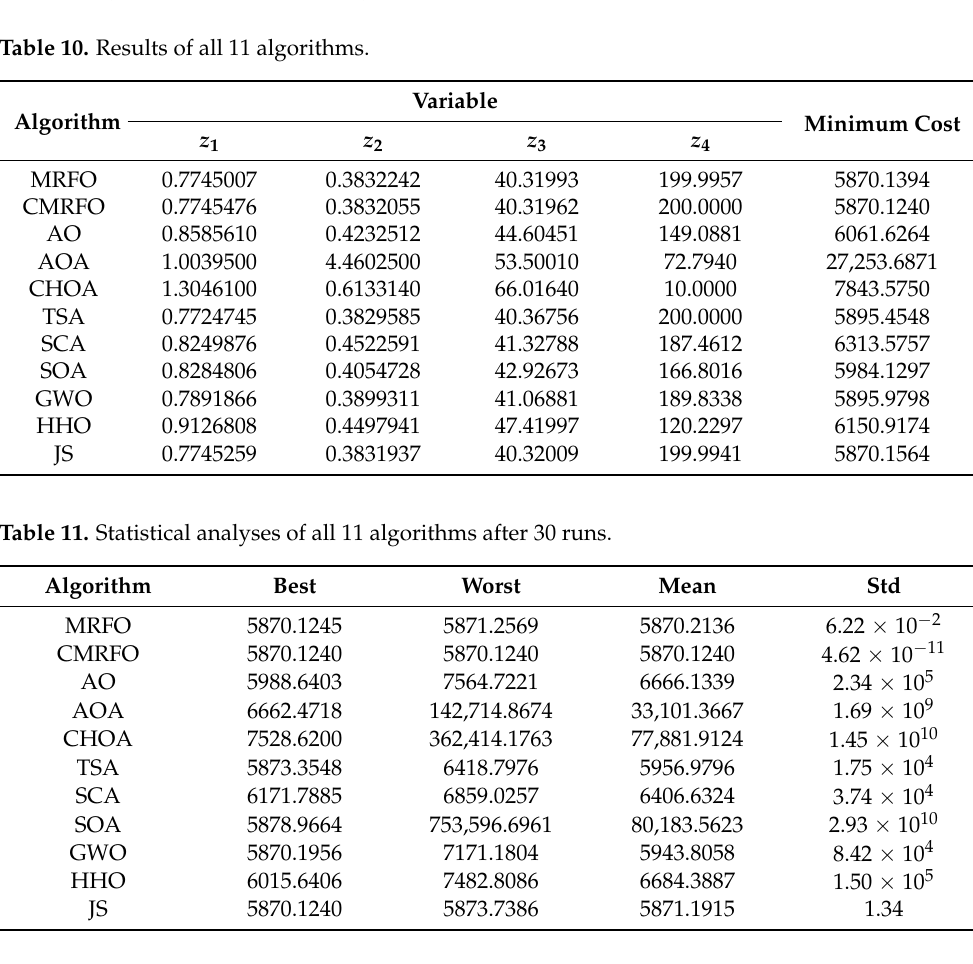
Table 10. Results of all 11 algorithms.